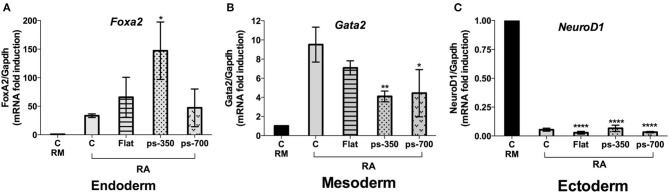
The Zscan4 expression is required for endodermal differentiation. The ESZscan_Em cells were cultured for 72 h on control plates (CTR, RM and RA), Flat, ps-350, and ps-700 treated with RA. mRNA expression levels of differentiation genes: Foxa2 (endoderm) (A), Gata2 (mesoderm) (B), and Neurod1 (ectoderm) (C) were assessed by qPCR and normalized to RM condition. Error bars represent SD of triplicate samples from three independent biological replicates. Asterisks indicate significant differences with respect to the CTR-RA condition. Levels of significance are: ns > 0.05; *p < 0.05; **p < 0.01; ****p < 0.0001.